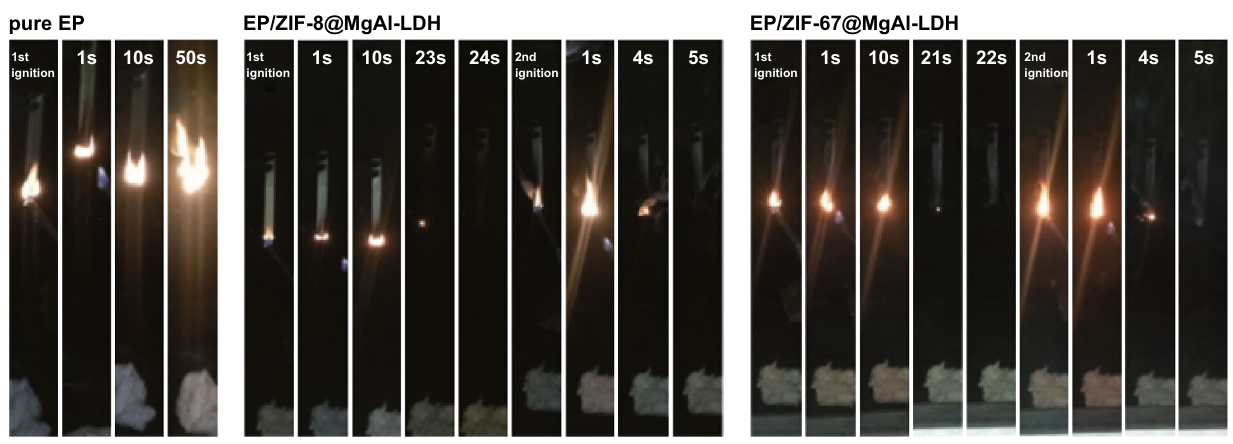
Fig. 14 Digital photographs of EP, EP/ZIF‑8@MgAl‑LDH and EP/ZIF‑67@MgAl‑LDH during the UL94 vertical burning test process. Repro‑ duced from Ref. [77] with permission from Elsevier